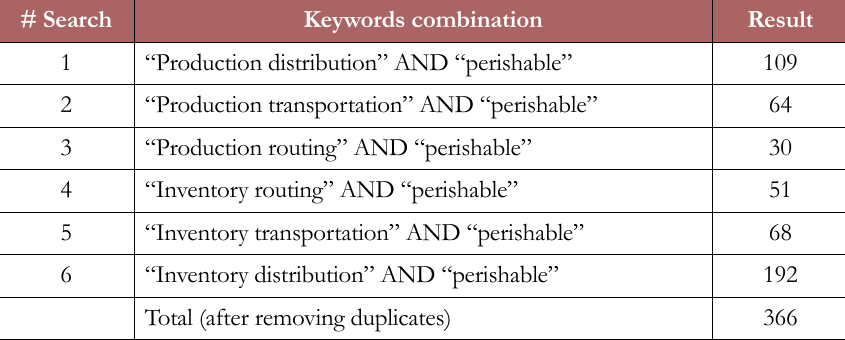
Table 2. Database queries: results